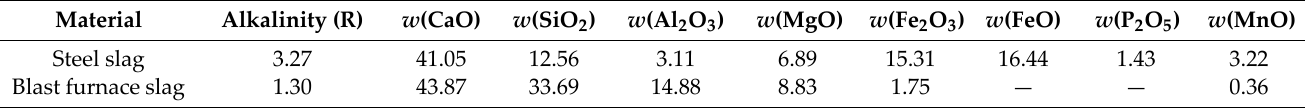
Table 1. Slag proportion and chemical composition (mass fraction, %).